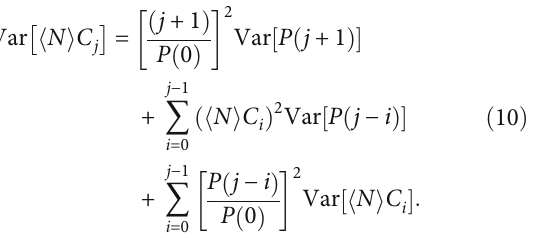
Figure 3: Ratio R = P Figure 1 (red circles) and of the corrected ratio R = P ð N Þ (black squares). P MSGD2